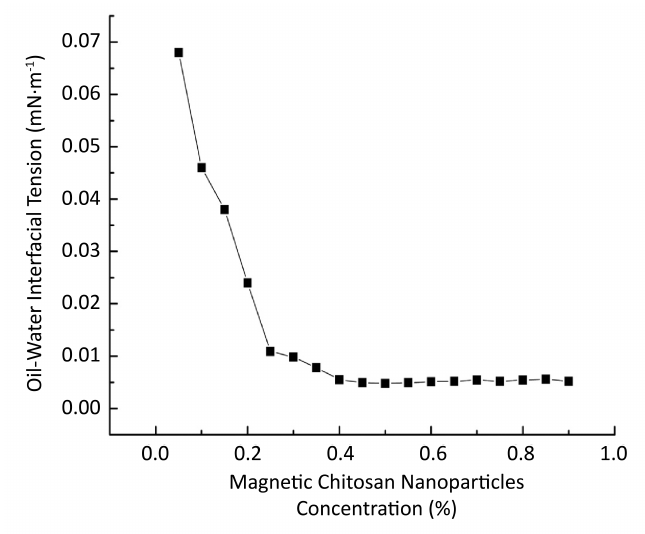
Figure 7. The effects of CoFe 2 O 4 –chitosan nanoparticles on interfacial tension (IFT). Figure reproduced from Ref.